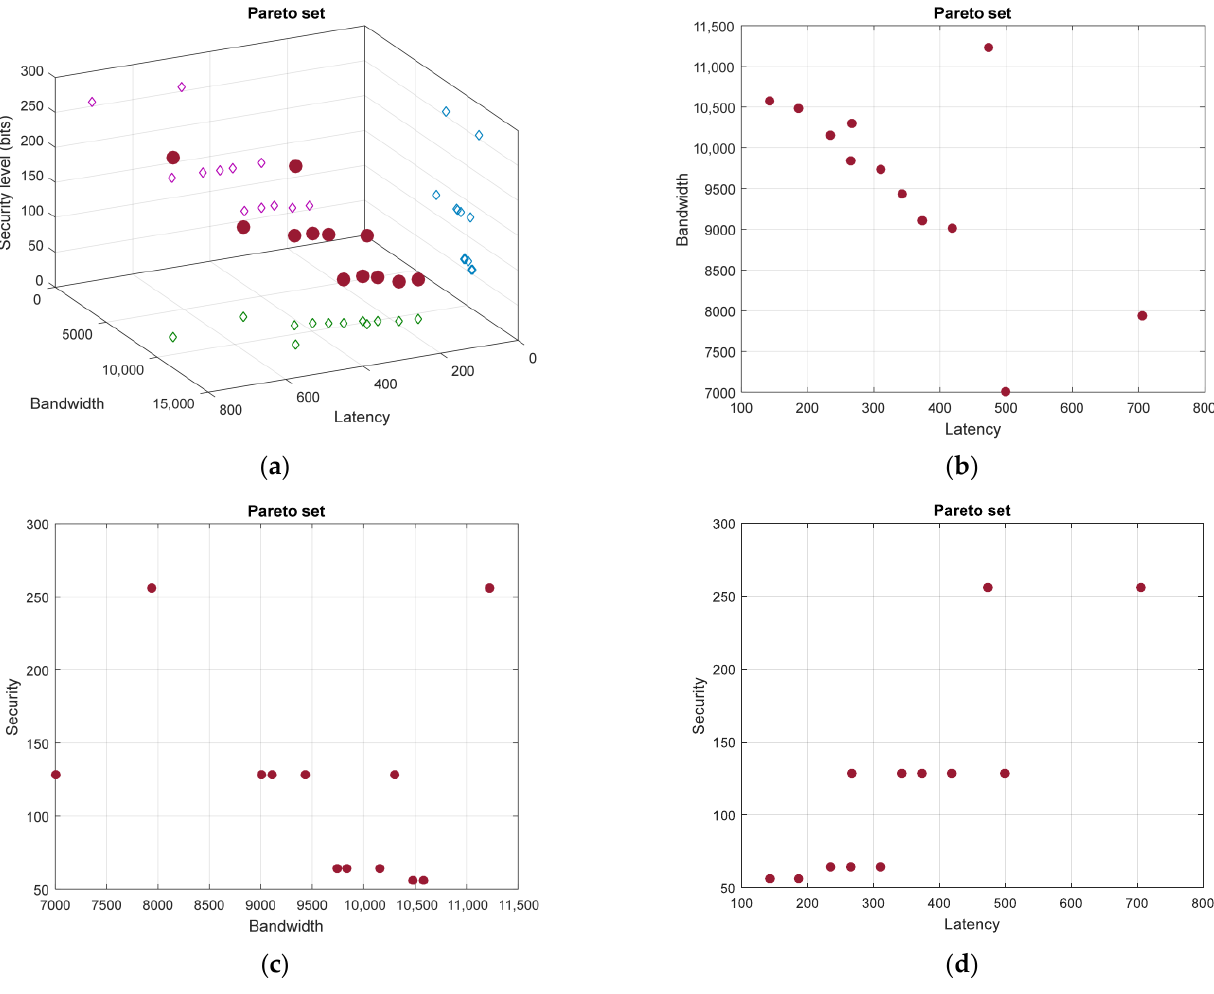
Figure 12. The Pareto set for graph B (three objective functions are used): ( a ) three-dimensional view of the Pareto set; ( b ) bandwidth–latency projection of the Pareto set; ( c ) security–bandwidth projection of the Pareto set; and ( d ) security–latency projection of the Pareto set.